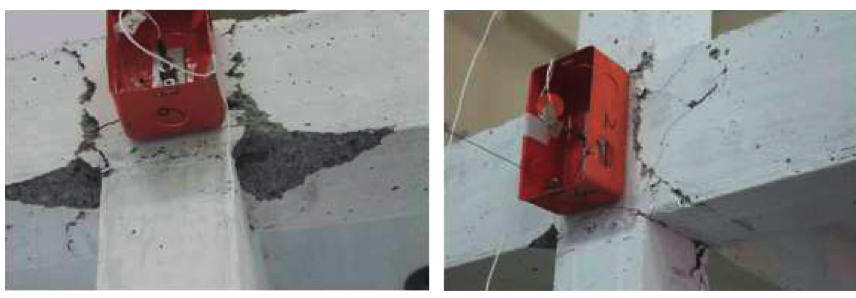
Figure 4: Observed damages in Model-1 (refer Table 1 for damage evolution; figure is reproduced from Ahmad et al.